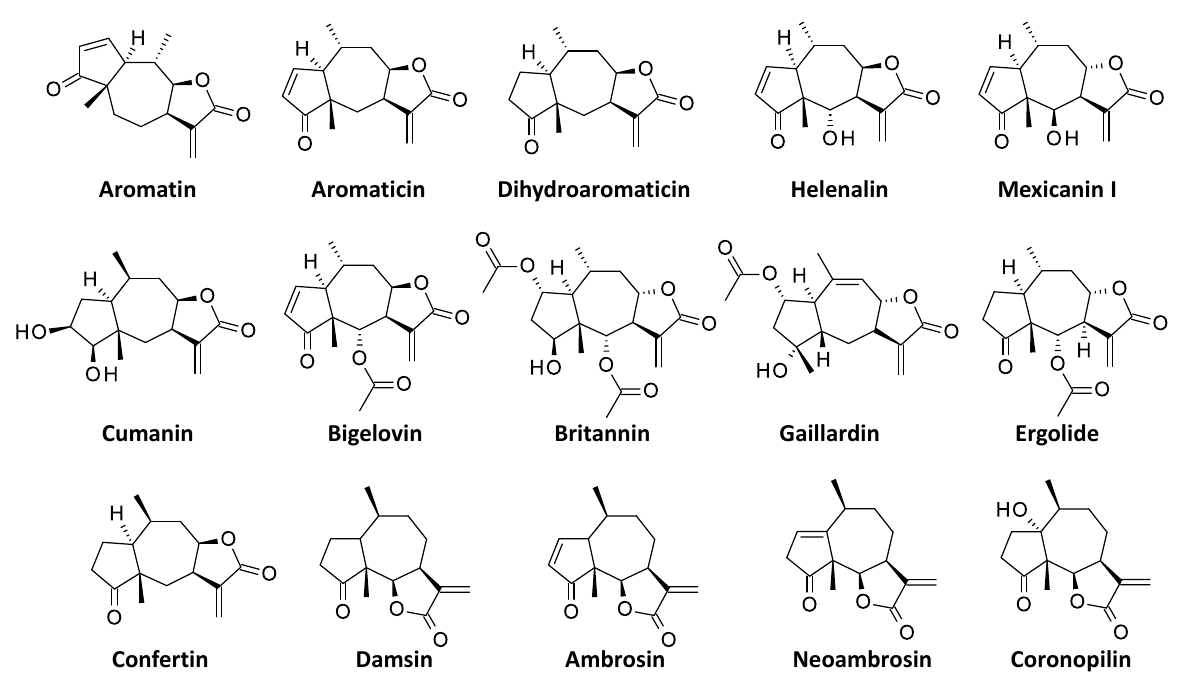
Figure 3. Structures of different pseudoguaianolide-type sesquiterpene lactones. The lactone ring can be cis - or trans - annelated to the seven-membered ring via the 7,8-positions (as for BRT) or via the 6,7-positions (as for damsin, (neo)ambrosin, and coronopilin). Pseudoguaianolides with a 15-methyl group on C-5 differ from pseudoguaianolides which have the methyl group on